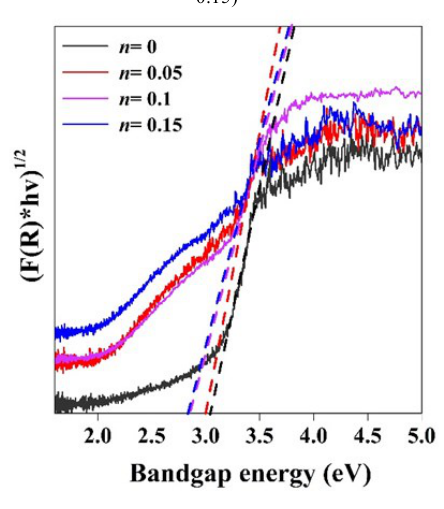
Fig 5. The Tauc-plot of SrBi 4 Ti 4- n V n O 15 ( n = 0, 0.05, 0.1, and 0.15)